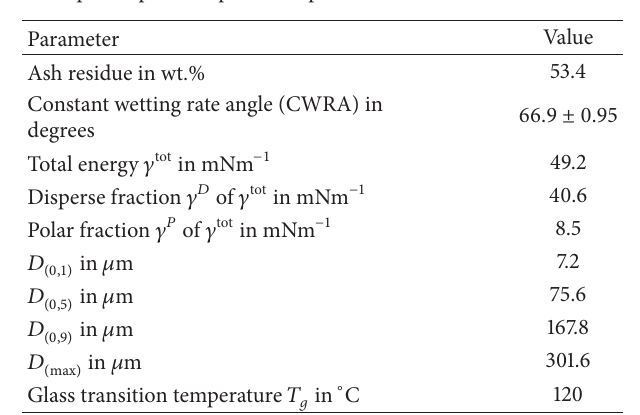
Table 1: Material properties of the PMMA/ATH powder used for atmospheric pressure plasma deposition.